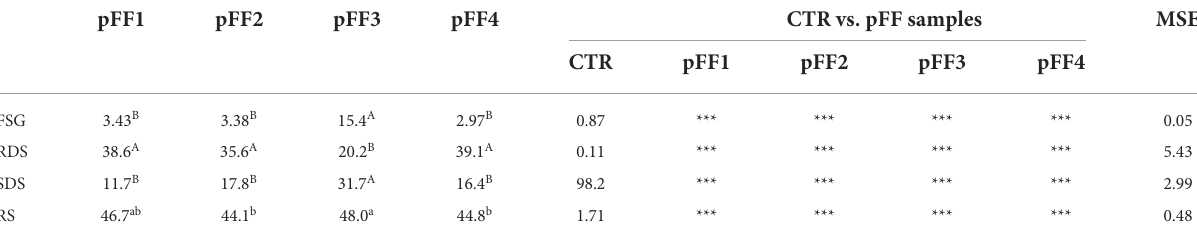
TABLE 3 In vitro starch digestibility of pasta former foods (% of total starch) ( n = 4).